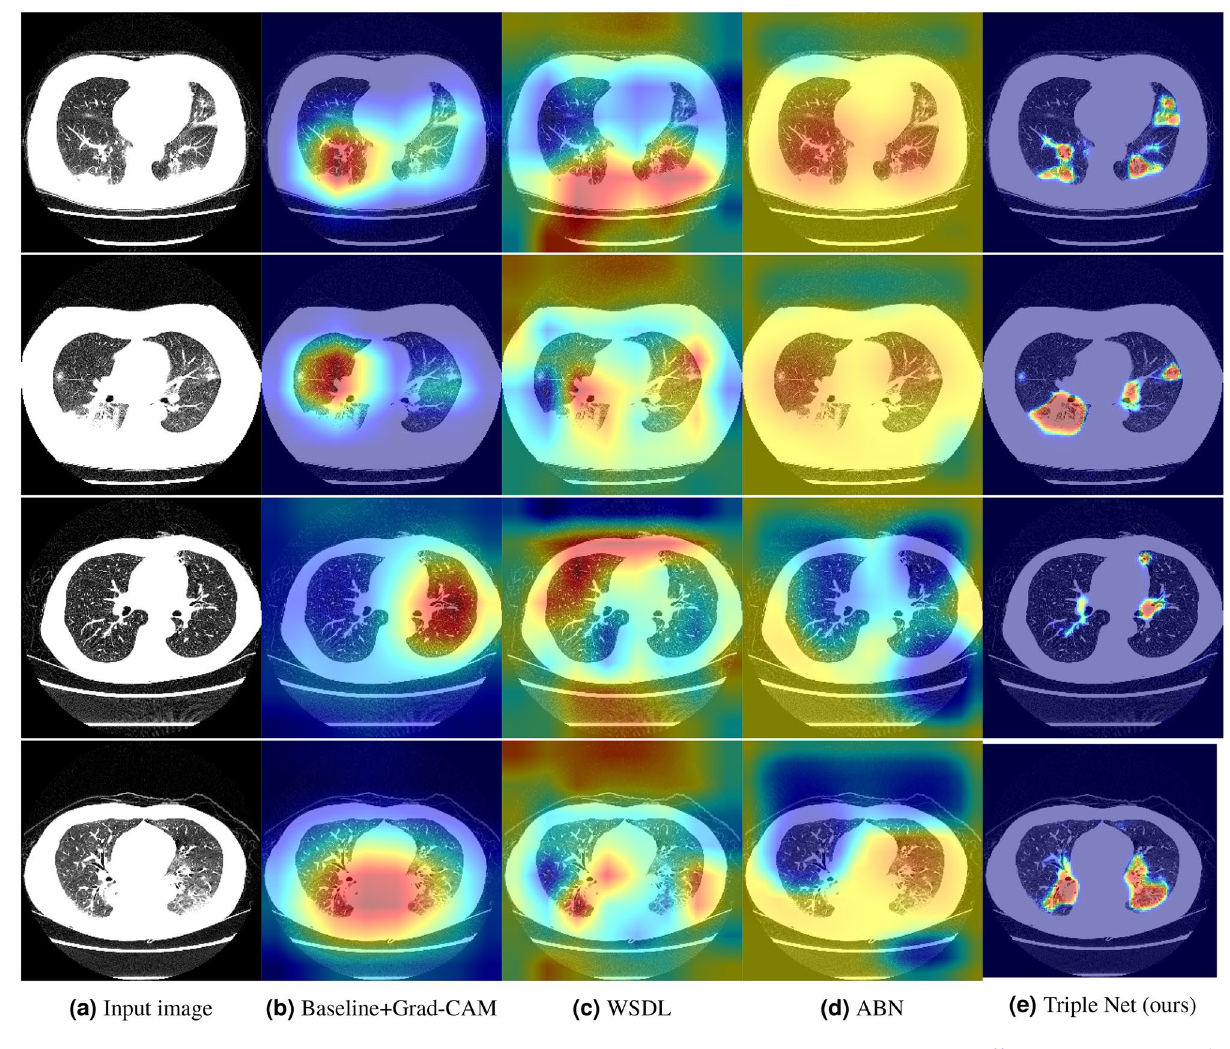
Figure 6. Results of visual explanation. ( a ) Input image, ( b ) baseline with Grad-CAM 23 , ( c ) WSDL with CAM 4 , ( d ) attention map using an ABN 44 , and ( e ) the attention map achieved by Triple Net (ours). All explanation images are a superposition of input images and heat maps. Red shows the most important location, and blue indicates an unimportant location for classification.